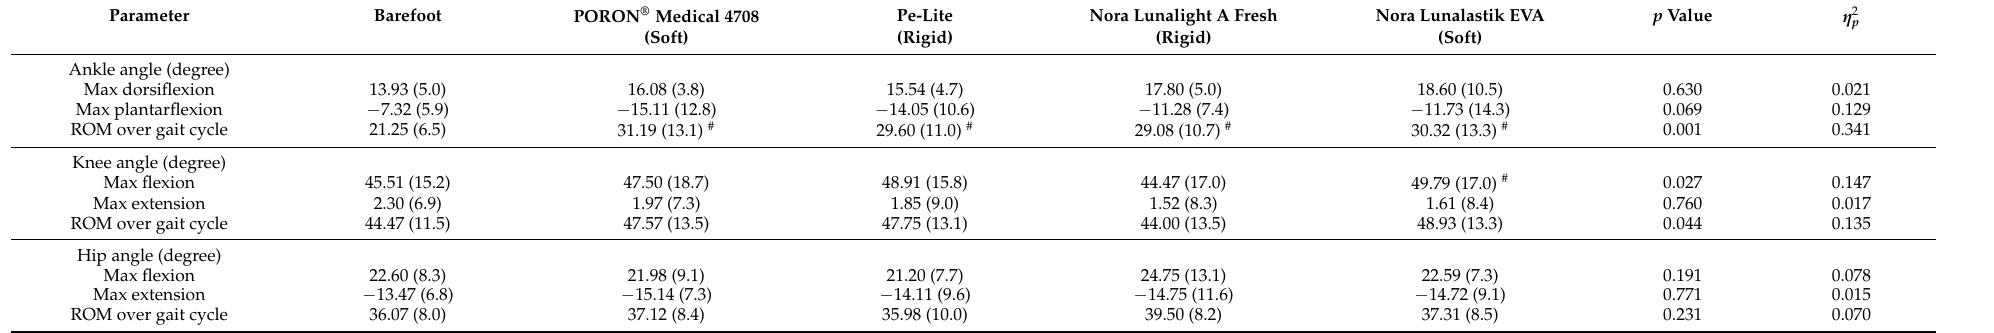
Table 2. Statistical results for kinematics parameters with and without insoles (mean (SD)).